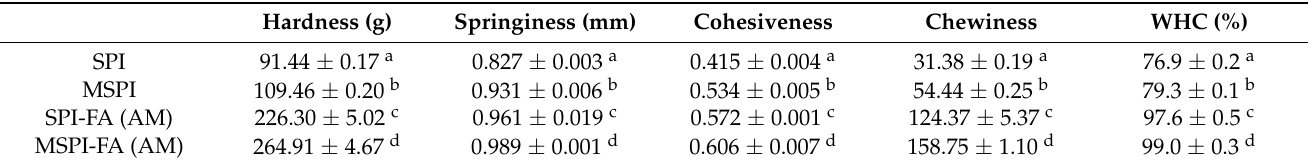
Table 5. Texture properties and WHC of emulsion gels induced by different modified soybean